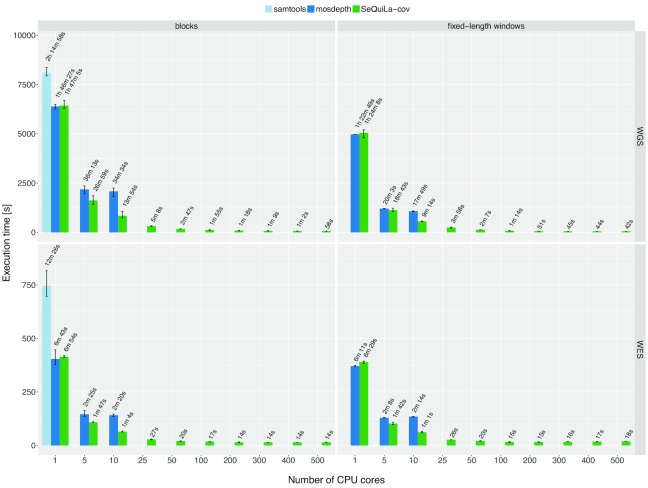
Performance and scalability comparison of samtools, mosdepth, and SeQuiLa-cov. Each experiment setting was repeated several times. Bar height and error bars indicate mean and range of execution time, respectively. The best pileup-based solution is definitely slower (2 times for WGS calculations) than both event-based solutions, which clearly shows the superiority of the latter one. Mosdepth execution time scales up to 5 cores; afterwards it shows no further gain in performance. SeQuiLa-cov has nearly the same execution time results as mosdepth for both block and window calculations for a single core, but scales out desirably using all 500 CPU cores on cluster nodes and at the same time performing WGS calculations in <1 minute.